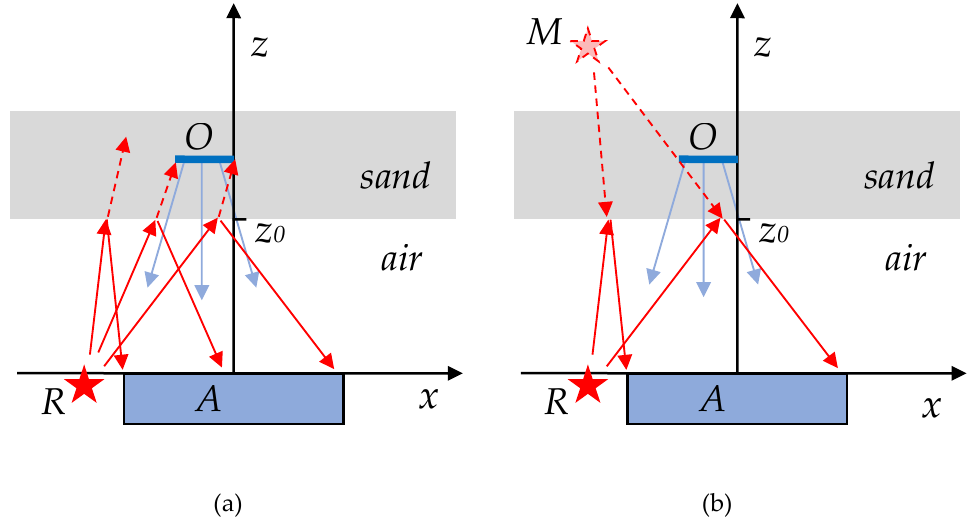
13b. The experiment confirms this hypothesis.